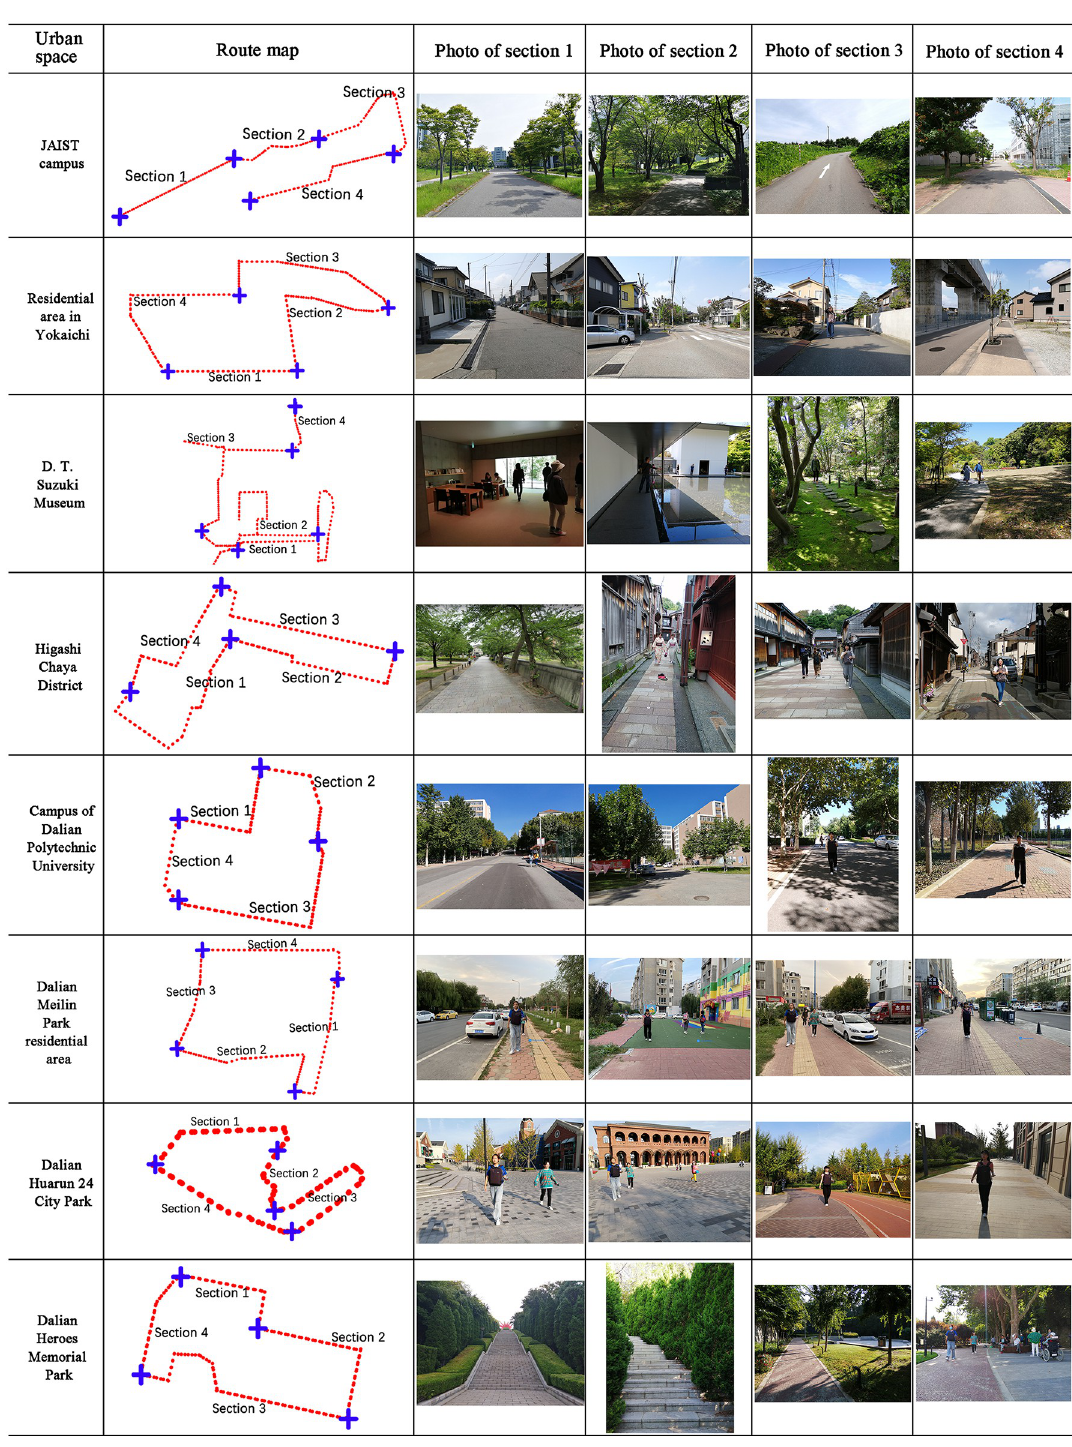
Fig 2. Route maps and photos of each section in the eight spaces; their data were used for model training and testing.